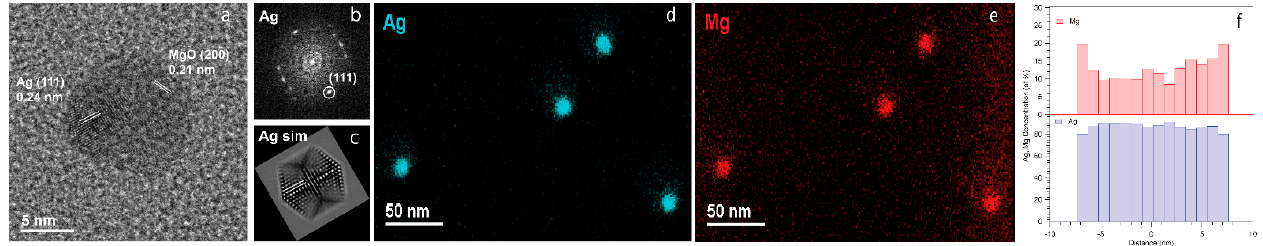
Figure 2. ( a ) Bright ‐ field HRTEM image of an Ag/MgO NP. The lattice fringes from Ag (111) planes are shown in the left part of the NP. Planes assigned to MgO (200) are shown in the top right of the NP image. ( b ) FFT image from the Ag domain, and ( c ) simulated image from an Ag ideal icosahedral domain oriented along the 2 ‐ fold axis. ( d ) EDXS map of Ag ‐ L edge intensity (cyan), ( e ) EDXS map of Mg ‐ K edge intensity (red). ( f ) EDXS profile for Ag and Mg content (atomic %) from a single NP.